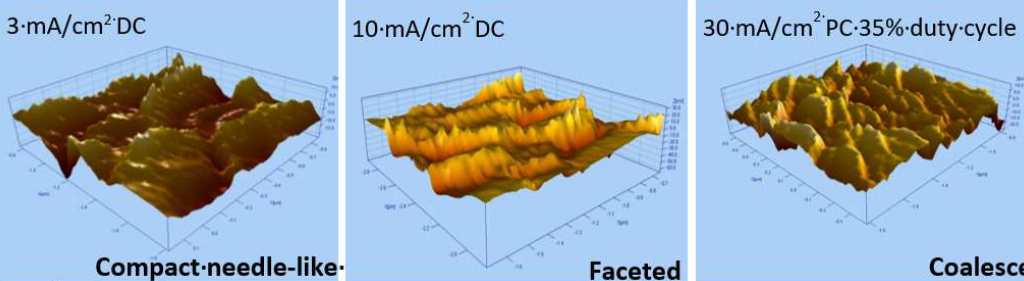
Figure 6. Atomic force microscopy (AFM) maps of needle-like, faceted, and coalesce domains in the Pd film.